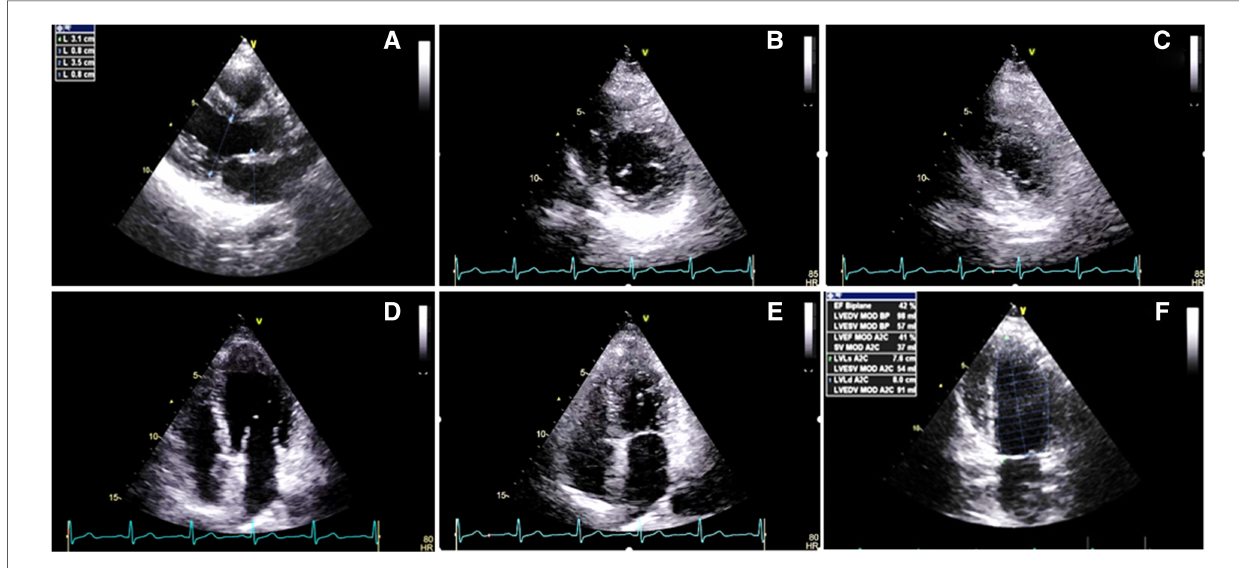
FIGURE 1 Two-dimensional transthoracic echocardiography 1 week before the radiotherapy course ( A – F ), illustrating the normal thickness of the left and right ventricular walls, in addition to global mild left ventricular systolic dysfunction: ( A ) PLAX view. ( B ) PSAX in the end-diastole. ( C ) PSAX in the end-systole. ( D ) A4C view in the end-diastole. ( E ) A4C view in the end-systole. ( F ) LV EF=42% by Simpson ’ s method. PLAX, parasternal long axis view; PSAX, parasternal short axis view; A4C, apical four chamber view.